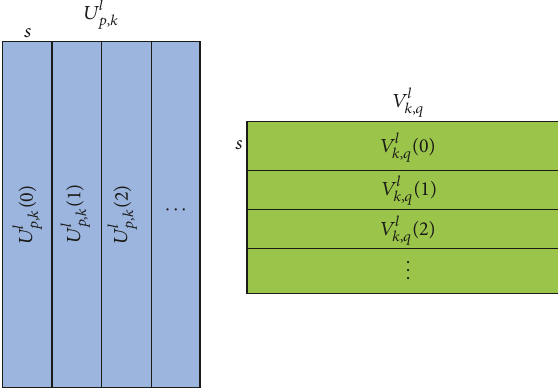
Figure 4: The segmentation